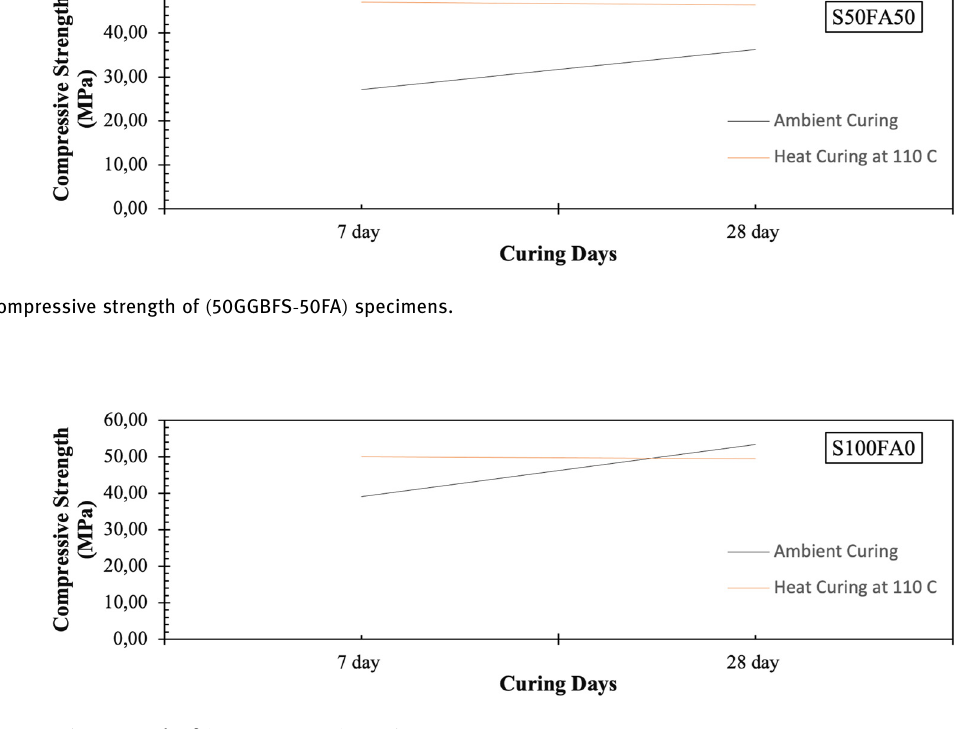
Figure 7: Compressive strength of ( 100GGBFS - 0FA ) specimens.